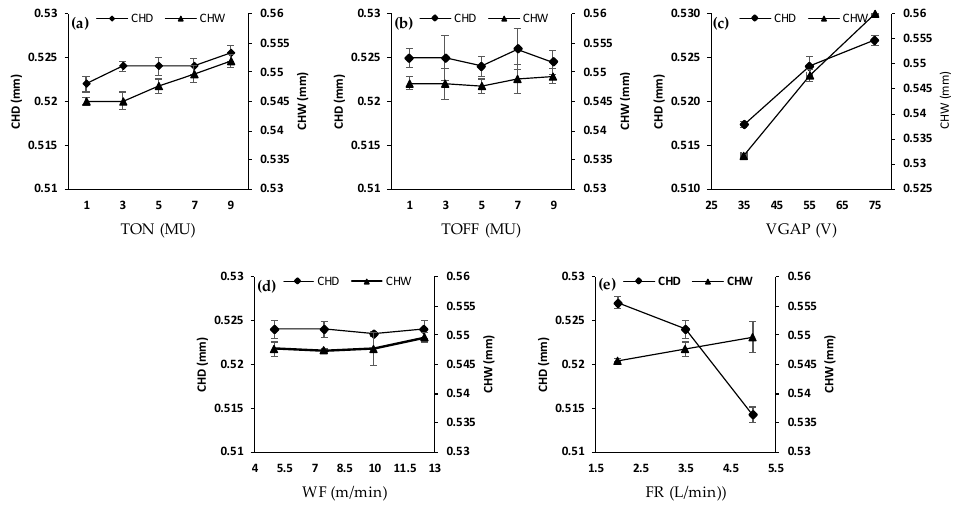
Figure 6. E ff ect of ( a ) pulse-on time, ( b ) pulse-o ff time, ( c ) average voltage gap, ( d ) wire feed and ( e ) flow rate on microchannel width CHW and depth